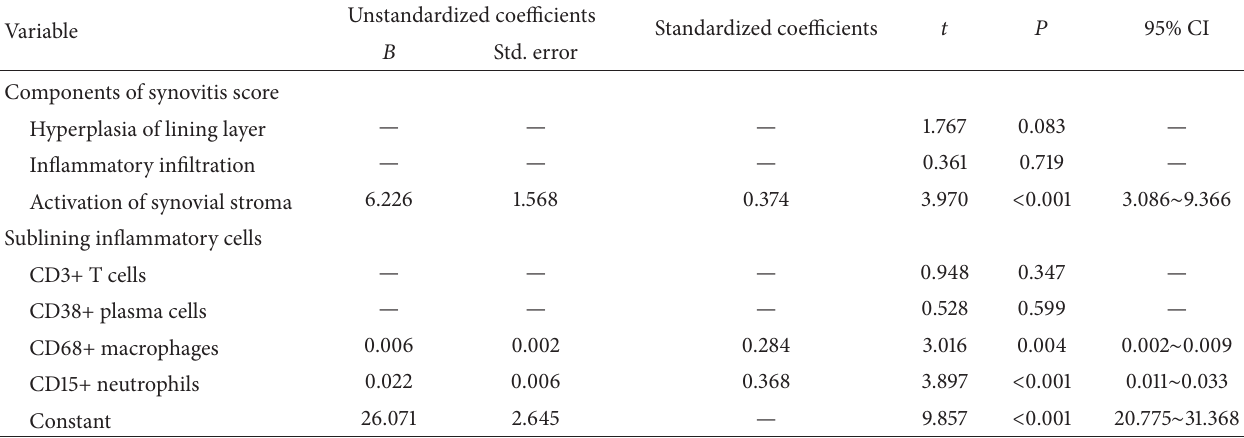
Table 3: Multiple linear regression analysis of variables associated with synovial